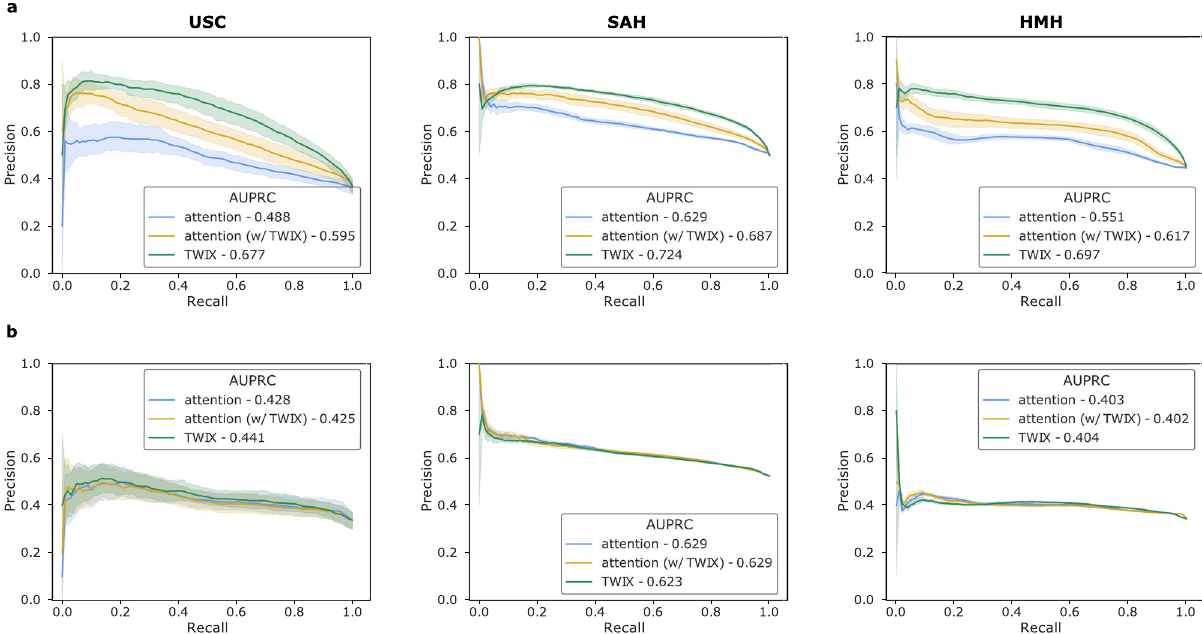
Fig. 3 TWIX can improve the reliability of AI-based explanations across hospitals. Precision-recall curves re fl ecting the alignment of different AI-based explanations with those provided by humans when assessing the skill-level of a , needle handling and b , needle driving. Note that SAIS is trained exclusively on data from USC and then deployed on data from USC, SAH, and HMH. The solid lines and shaded areas represent the mean and standard deviation, respectively, across 10 Monte Carlo cross-validation